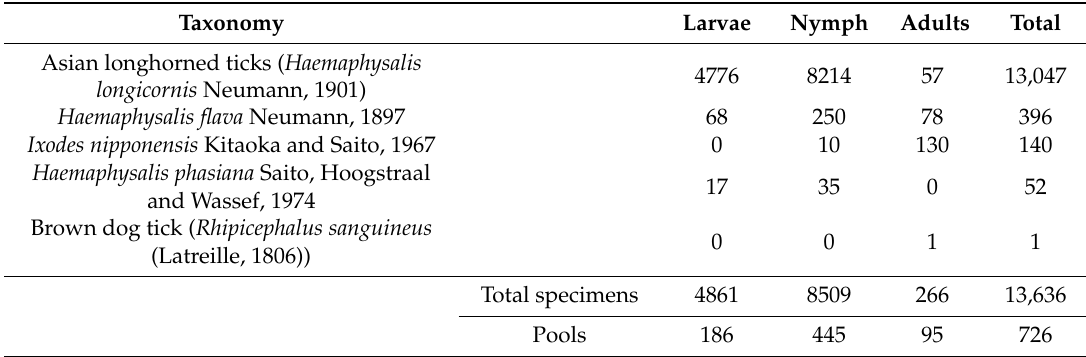
Table 1. Total number of tick specimens and pools distributed by species and lifecycle stage and analyzed for the presence of SFTSV by